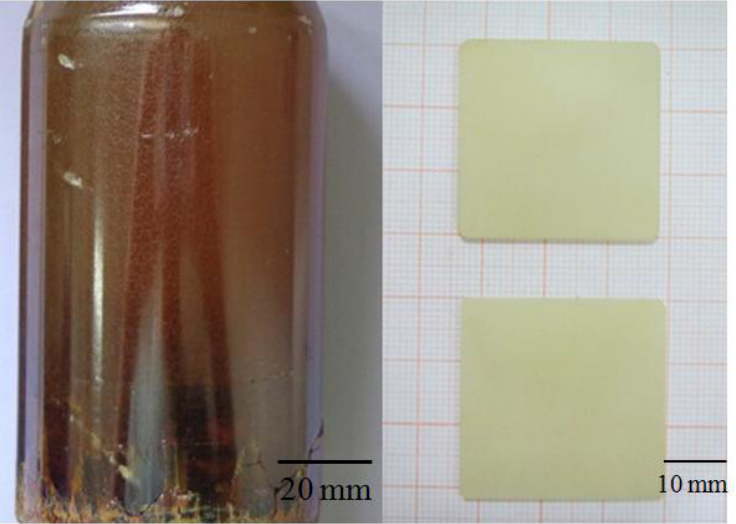
Figure 1. Large-size and high-quality PMN-PT single crystal grown at the Shanghai Institute of Ceramics by the modified Bridgman technique.